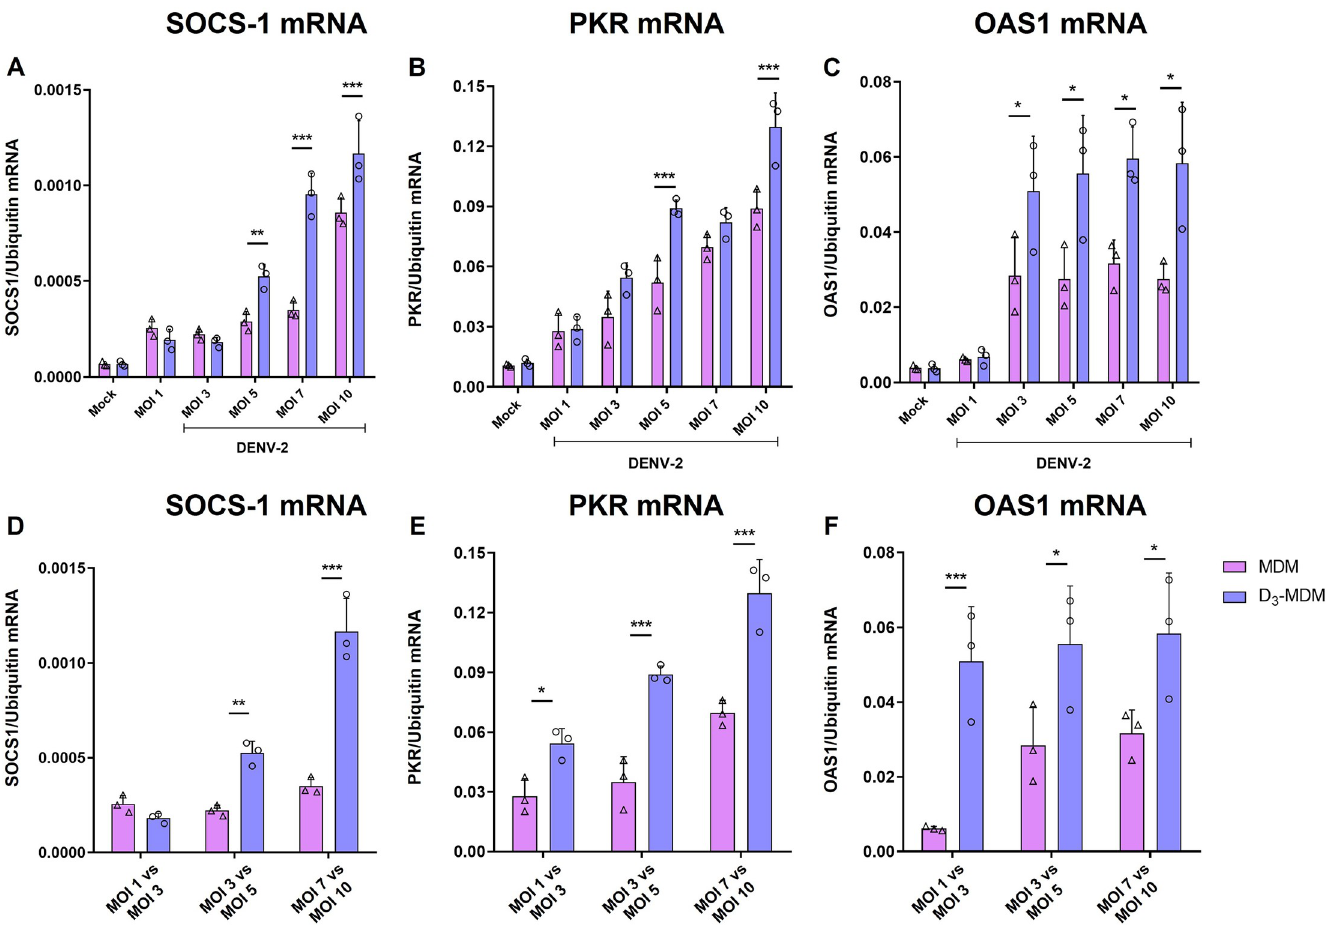
Fig 6. Regulation of SOCS-1 and ISGs expression is independent of the MOI used. The MDMs were differentiated in the presence of VitD3 (0.1 nM) for 6 days (D 3 - MDMs) and then infected with DENV-2 with different MOIs for 24 h. Expression of SOCS-1 (A and D), PKR (B and E), and OAS1 (C and F) were measured by qPCR in MDMs and D 3 -MDMs using ubiquitin as a housekeeper. Data are expressed as fold change relative to mock-treated MDMs and D 3 -MDMs. Three different donors were analyzed. Differences were obtained with a two-way ANOVA with a Bonferroni posthoc test and a 95% confidence interval ( ��� p < 0.001, �� p < 0.01, � p <